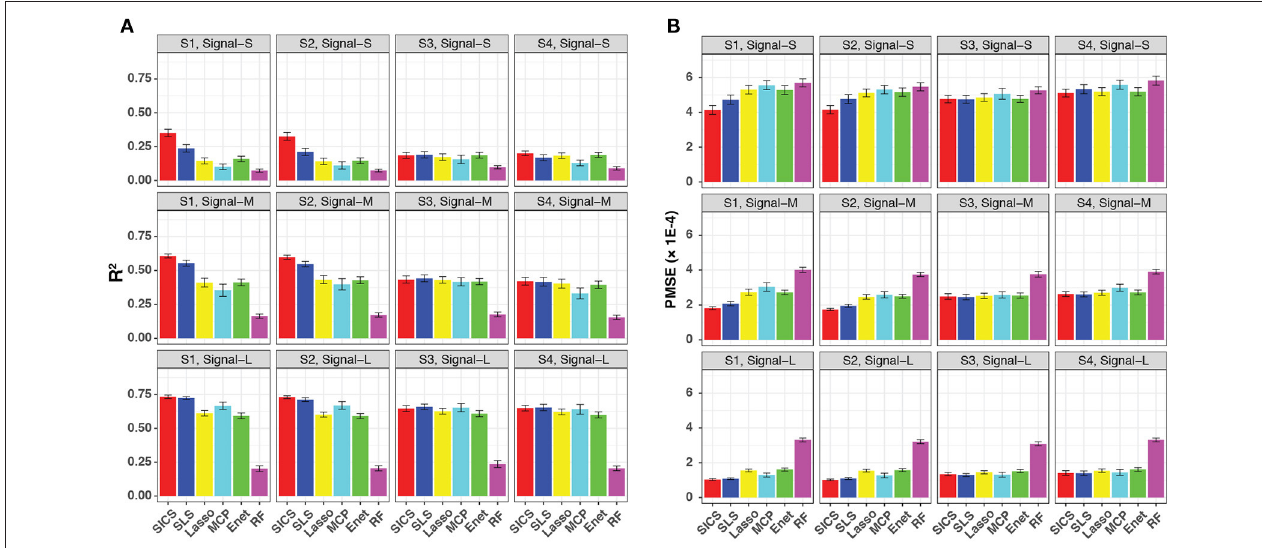
FIGURE 3 | Prediction performance for continuous-outcome simulations across different signal levels and scenarios. Both R 2 (A) and PMSE (B) were used for evaluation. S1, S2: phylogeny-informative scenarios, and S3, S4: phylogeny-non-informative scenarios; Signal-S, -M, and -L represent weak, medium and strong signals,